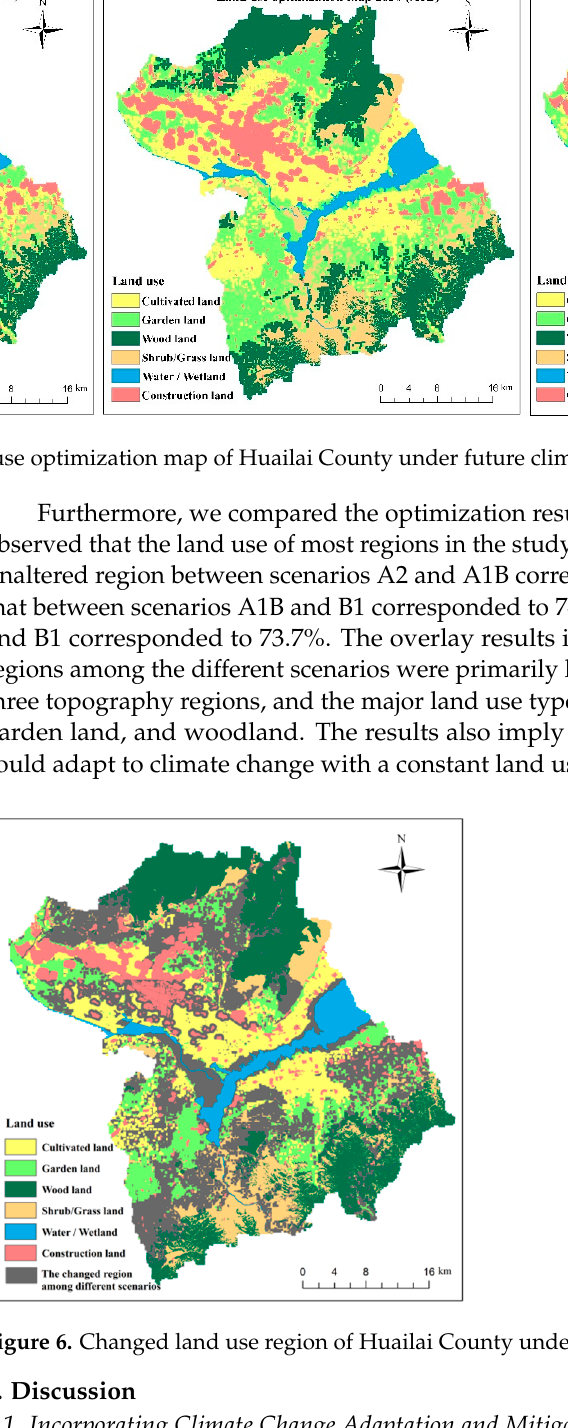
Figure 6. Changed land use region of Huailai County under different climate change scenarios.